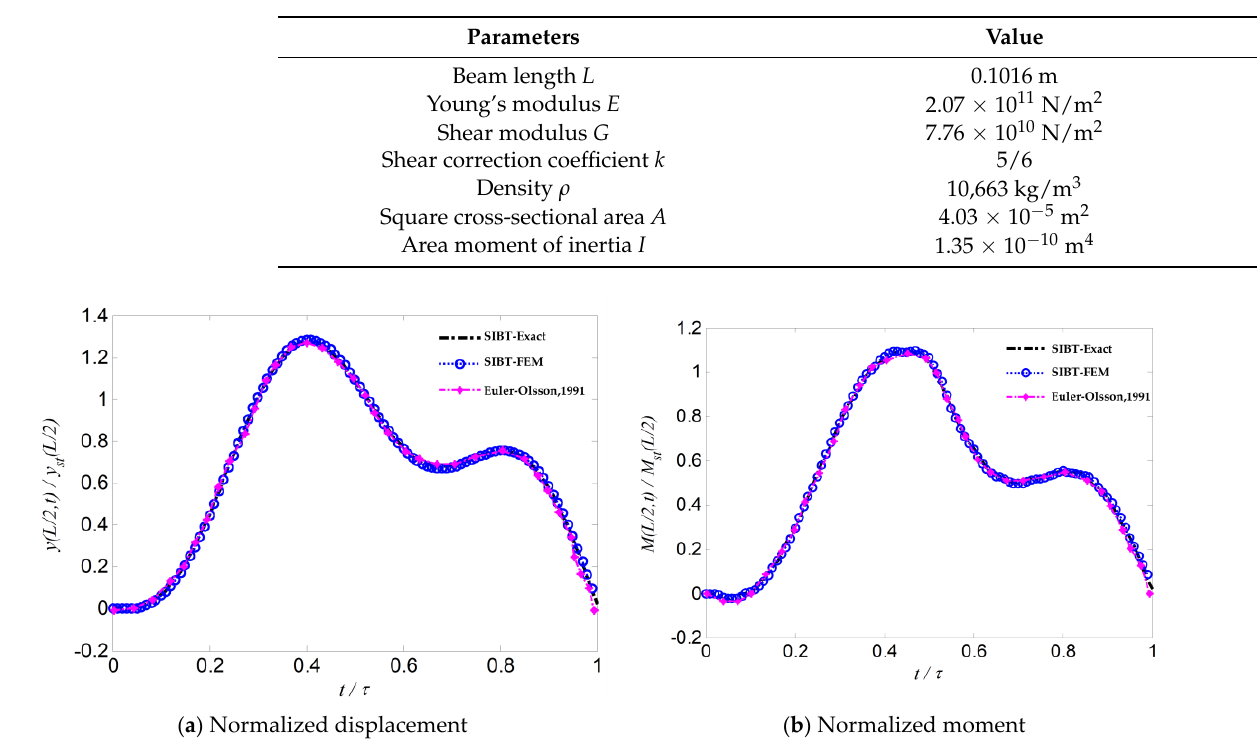
Table 2. Parameters and properties of the beam.